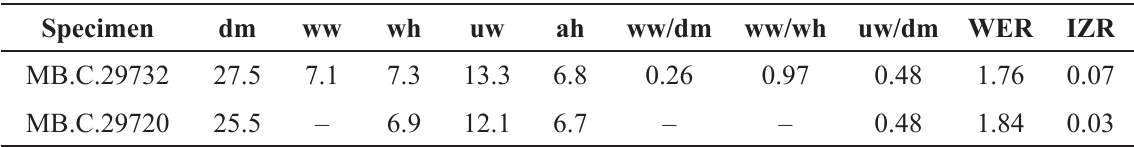
Table 5. Conch dimensions (partly estimated) and ratios of selected specimens of Arasella minuta (Zakharov in Kotlyar et al. 1983) from Baghuk Mountain.